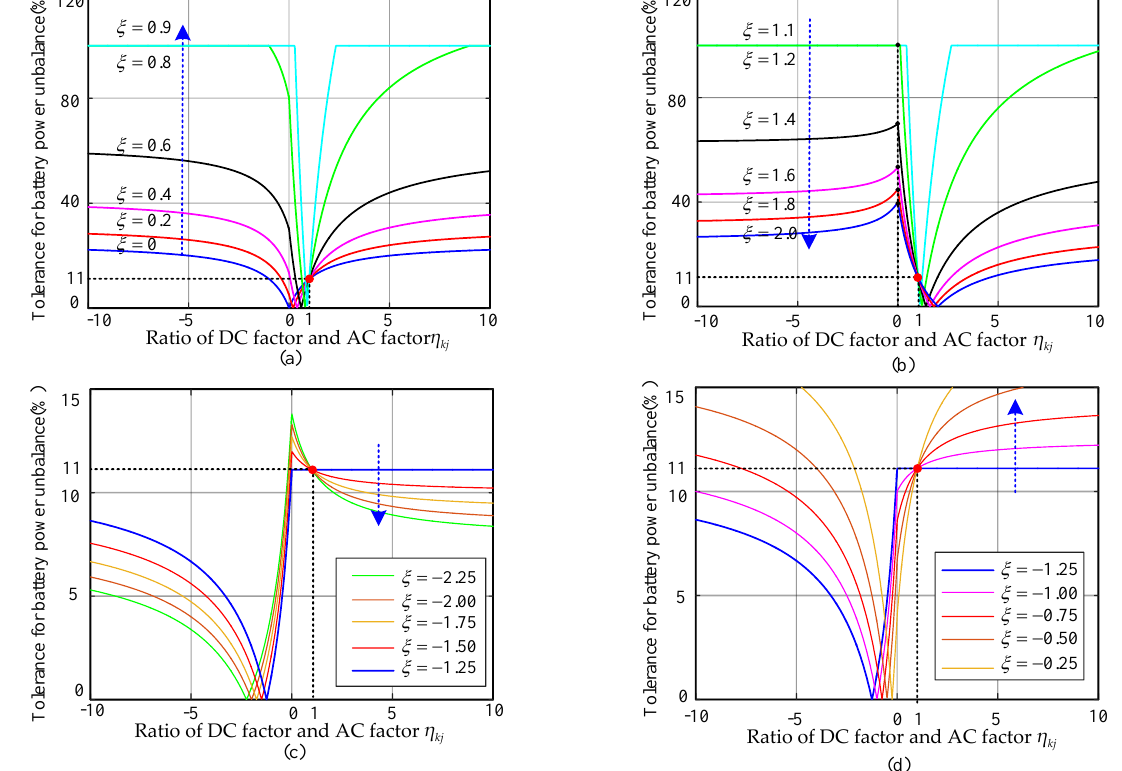
Figure 5. Power regulation capability of submodules when m = 0.8: ( a ) when power ratio 0 < ξ kj ≤